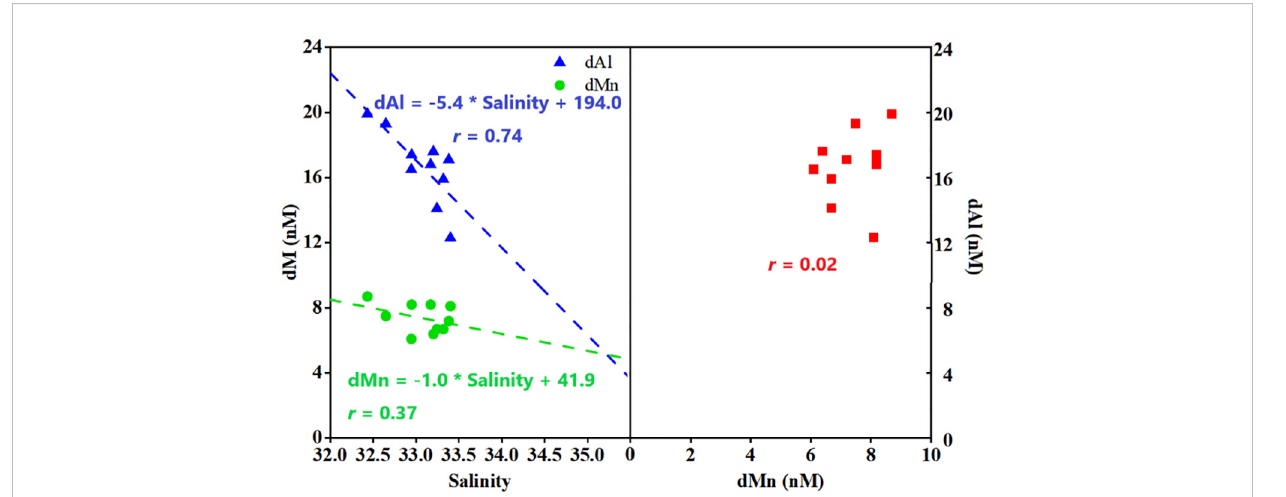
FIGURE 7 dAl and dMn variations with salinity in the mixed layer for stations in BoB (left). dMn variation with dAl in the mixed layer of BoB (right). dAl, dissolved aluminum; dMn, dissolved manganese; BoB, Bay of Bengal.